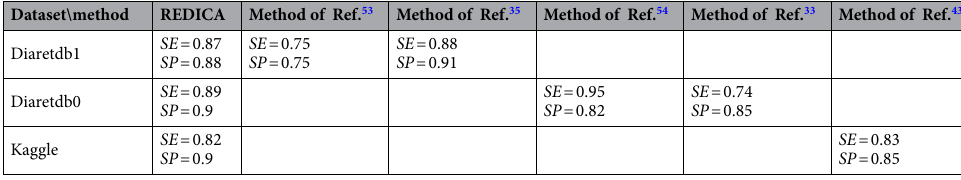
Table 2. SE and SP values of the methods of Ref. 35,53 for Diaretdb1, the methods of Ref. 33,54 , for Diaretdb0, the method 43 for Kaggle, and the REDICA method for all